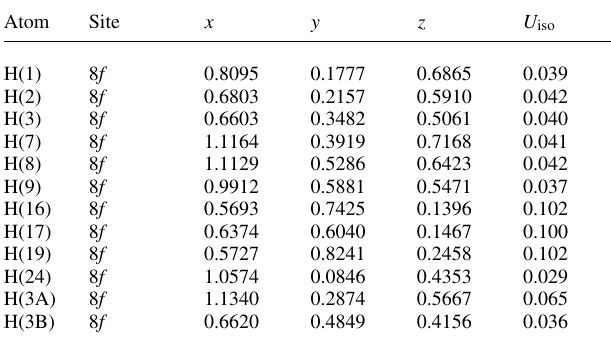
Table 2. Atomic coordinates and displacement parameters (in Å 2 )